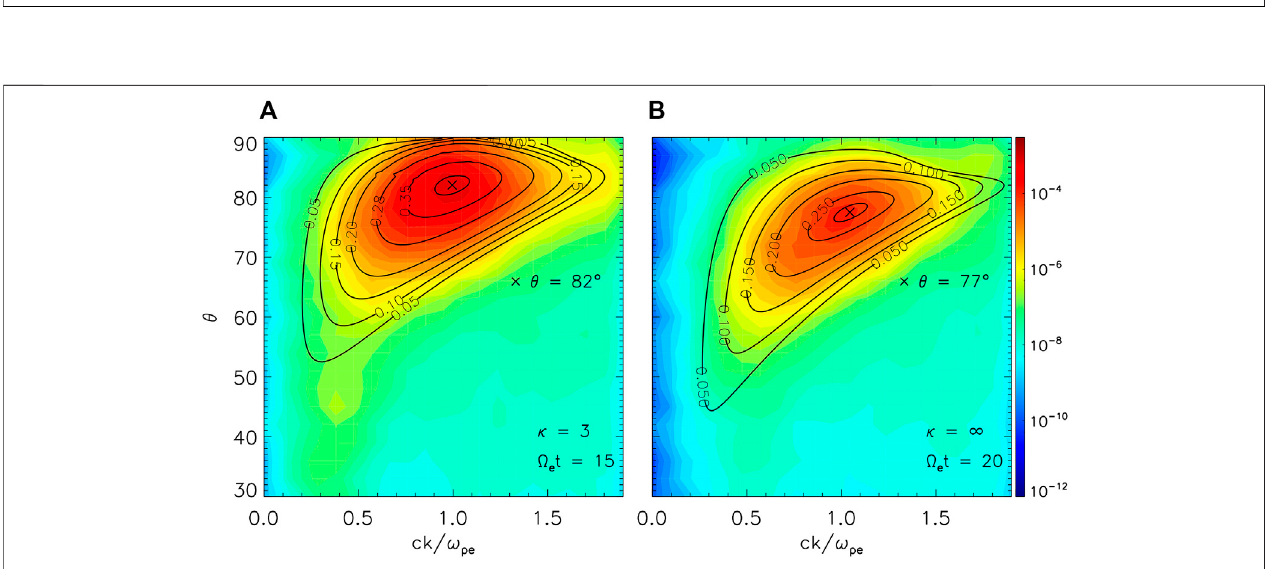
FIGURE 5 | Power spectra (color coded) ofO-EFH fl uctuations ( δ B z component) from PIC simulations, for bi-Kappa protons with κ e (cid:1) 3 (A) and bi-Maxwellian limit κ → ∞ (B) . Contours of the linear growth rates ( c / Ω e ) show a very good agreement with the simulations.